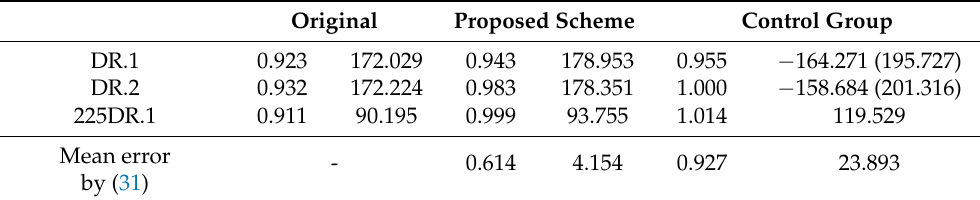
Table 4. Quality evaluation of DR.1–DR.2 and 225DR.1 in CQP SAR data set with additionally additive noise. The unit of measure in the second row, the fourth row, and the fifth row is dBs, and the unit of measure in the third row is degrees ( ◦ ). For obvious comparison, the values in brackets in the seventh column are in phase periods of 0 to 360 degrees. The last row shows the errors of the results of the proposed method and the control group compared to the corner reflectors by